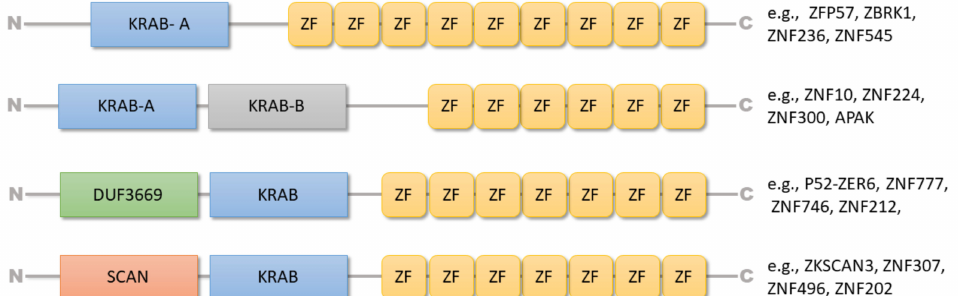
Figure 1. The structure of various Krüppel-associated box zinc finger proteins (KRAB-ZFP) factors and their composing domains. The diagram shows the structure of selected factors (based on the Uniprot database) containing a KRAB domain at the N-terminus and the variable number of zinc fingers at the C-terminus. A KRAB domain may consist of two boxes: KRAB-A and KRAB-B. In some of the KRAB-ZFPs, an additional “SRE-ZBP, CTfin51, AW-1 and Number 18 cDNA” (SCAN) or “domain of the unknown function” (DUF3669) may also be present.